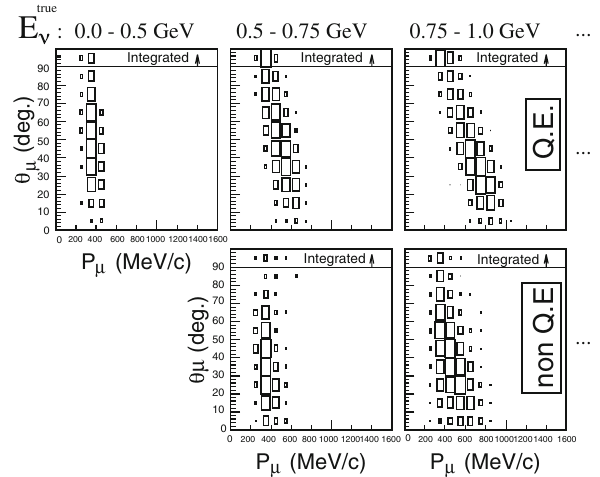
Fig. 26 MC expectation of ( p μ , θ μ ) distribution